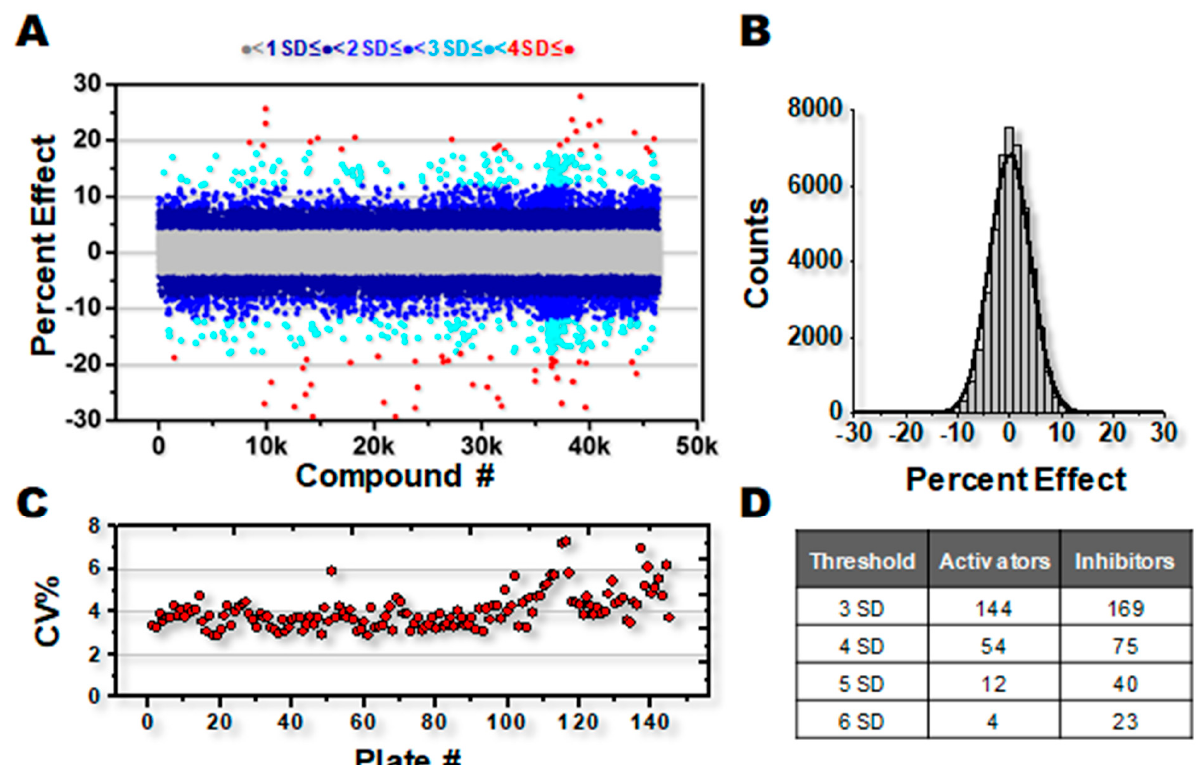
Figure 1. DIVERSet ATPase screen for SERCA effectors. ( A ) Percent change in ATPase activity for 46K compound screen. Selected activating compounds displayed in red. ( B ) Gaussian fit of percent effect distribution. ( C ) CV% for each assay plate. ( D ) Numbers of SERCA activating and inhibiting compounds that meet various SD thresholds above (activators) or below (inhibitors) the mean.